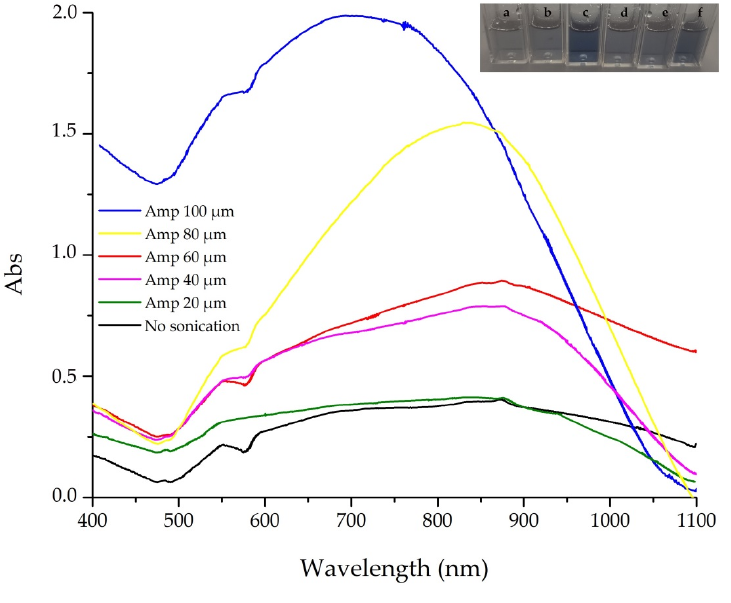
Figure 7. Absorption spectra of GNS prepared in different amplitudes—( a ) 0 µm, ( b ) 20 µm, ( c ) 40 µm, ( d ) 60 µm, ( e ) 80 µm and ( f ) 100 µm.